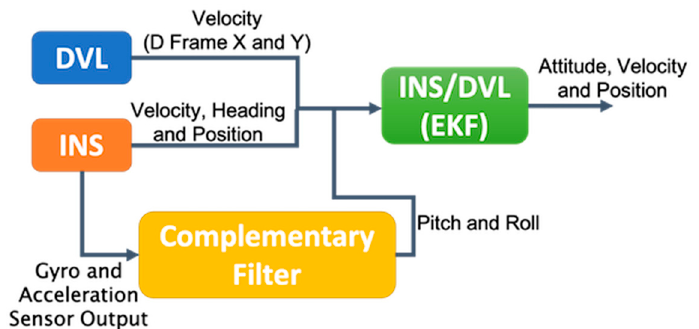
Figure 3. Loosely coupled INS/DVL EKF integration architecture.